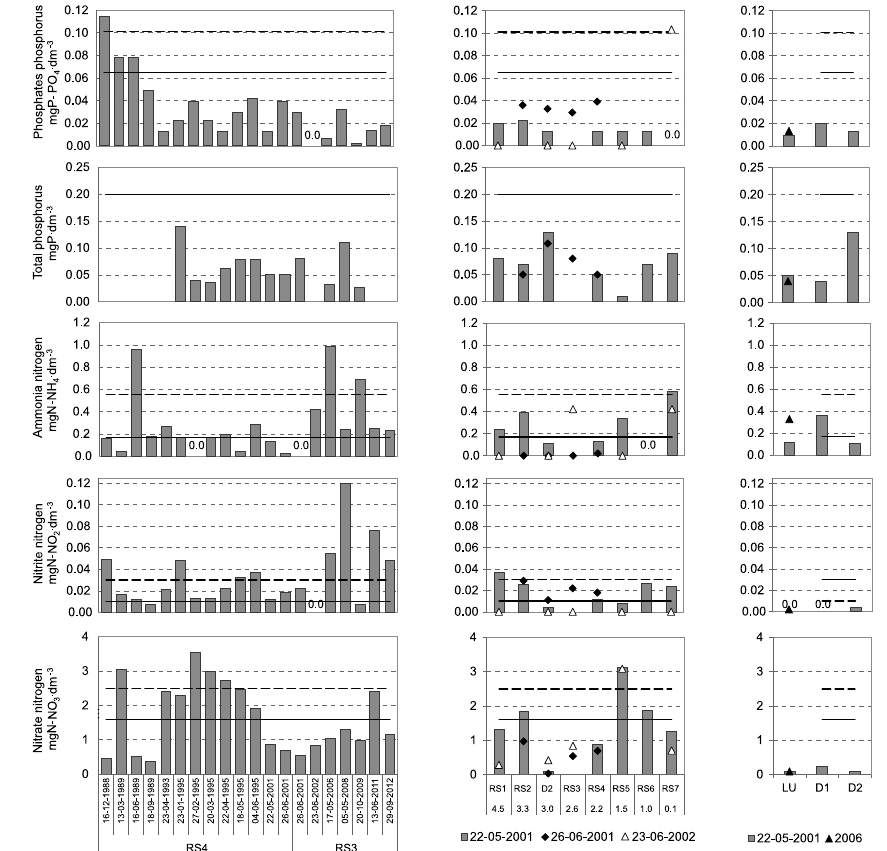
Fig. 12. Indicators of biogenic conditions: phosphates phosphorus, total phosphorus, ammonia nitrogen, nitrite nitrogen and nitrate